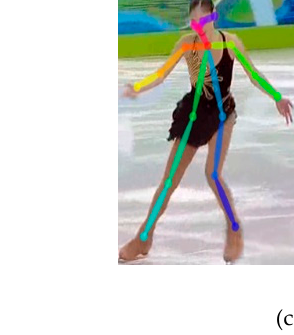
Figure 3. The pipeline of the action classification component. (The input of the action classification component was joint trajectories obtained by skeleton detection from an RGB video. Joint motion volume: A joint motion volume centered at each of the joint positions and comprised of the n × n spatial context was extracted to represent the movement of each joint. Local motion pattern representation: We employed the central moment features computed by the noise filtered joint motion volume to describe the motion patterns of each corresponding joint, and concatenated all joint features into the final motion descriptor. Bag-of-words (BoW) modeling: For the sake of alleviating intra-class variation, we employed bag-of-words feature modeling, which utilizes K-means feature clustering and cluster frequency statistics to form the final action representation of a video. Action classifier: The SVM classifier was developed from features of labeled training samples to determine the class label of action instance.).